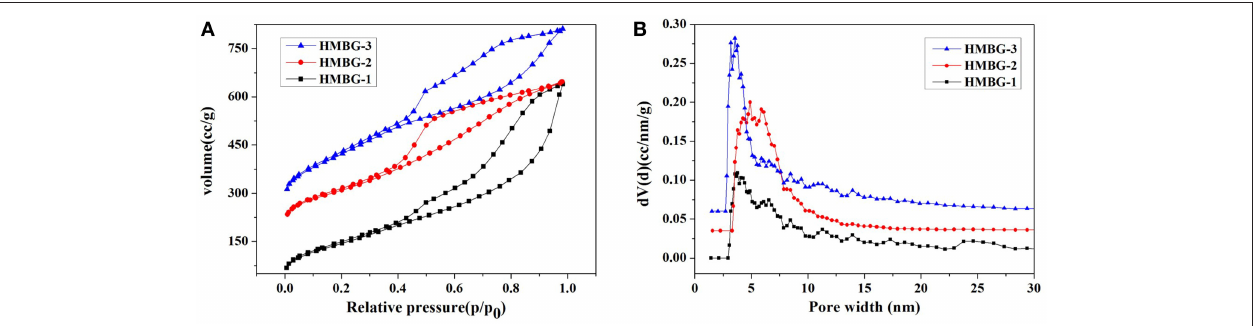
FIGURE 2 | N 2 absorption-desorption isotherm plots (A) and pore size distribution (B) of